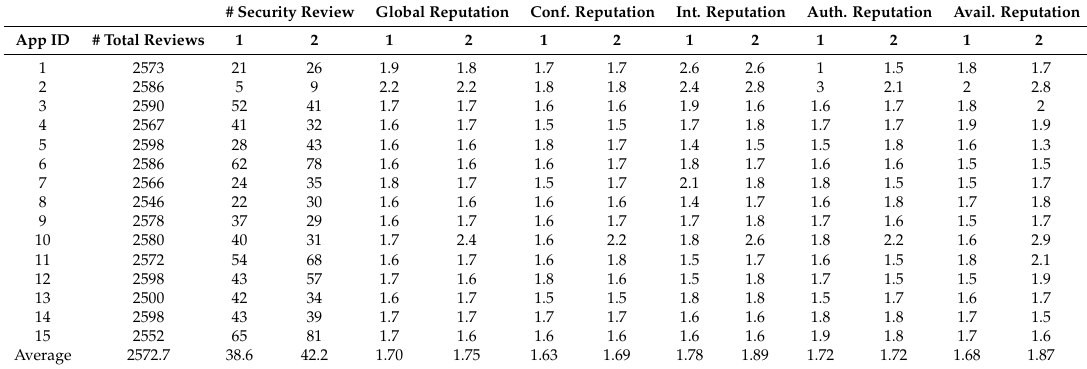
Table 10. SRR-Miner keywords vs. our approach’s keywords. Conf.: confidentiality, Int.: Integrity, Auth.: Authentication, Avail.: